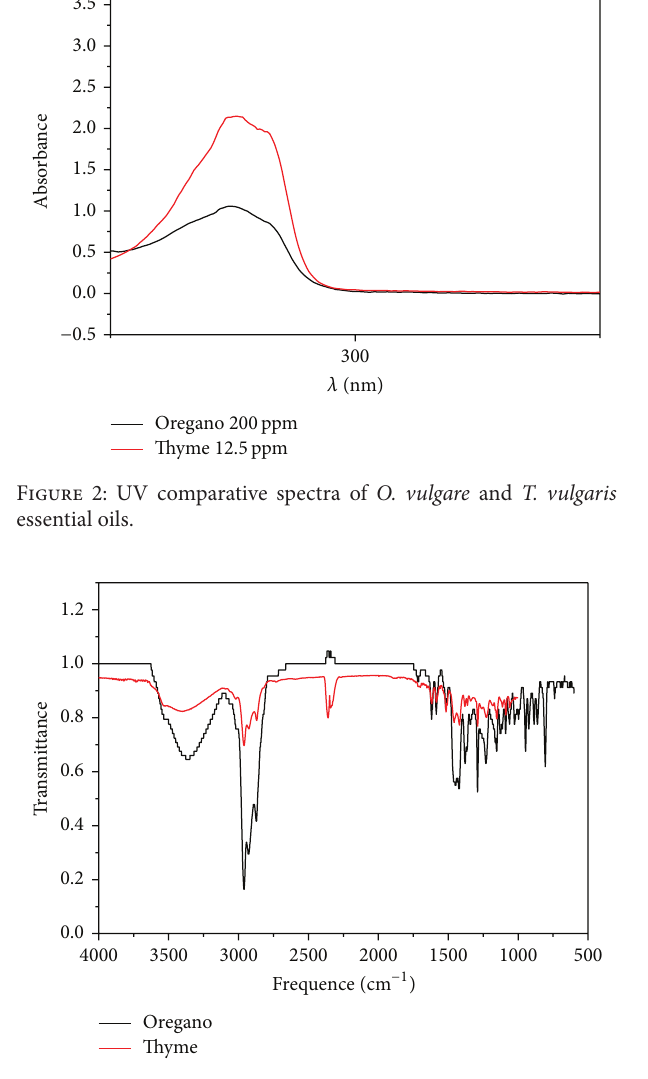
Figure 3: IR comparative spectra of O. vulgare and T. vulgaris essen- tial oils.